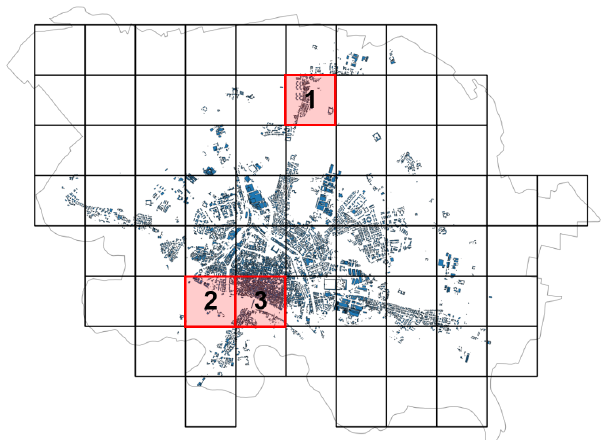
Figure 7. The 1km 2 grid adopted in the vector- and population- based exposure models. Grid cells (GC) highlighted in red are used to illustrate the differences between the two models.